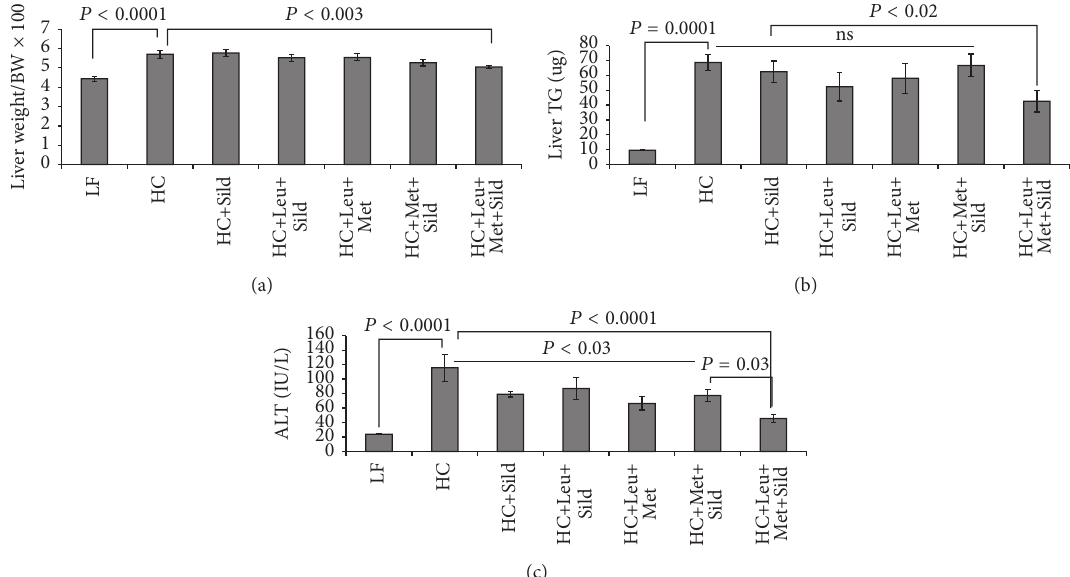
Figure 6: Sild-Met-Leu effects on liver weight, liver triglycerides, and ALT in mice. Mice were fed a low-fat (LF) diet or high-fat atherogenic (HC) diet for 6 weeks and then randomized to the indicated treatment groups for an additional 6 weeks. (a) Liver weight (expressed as ratio to total body weight), (b) liver triglycerides, and (c) alanine aminotransferase (ALT) were determined at the end of the study. Data are expressed as mean ± SEM ( 𝑛 = 5 to 8). Sild: sildenafil, Met: metformin, Leu: